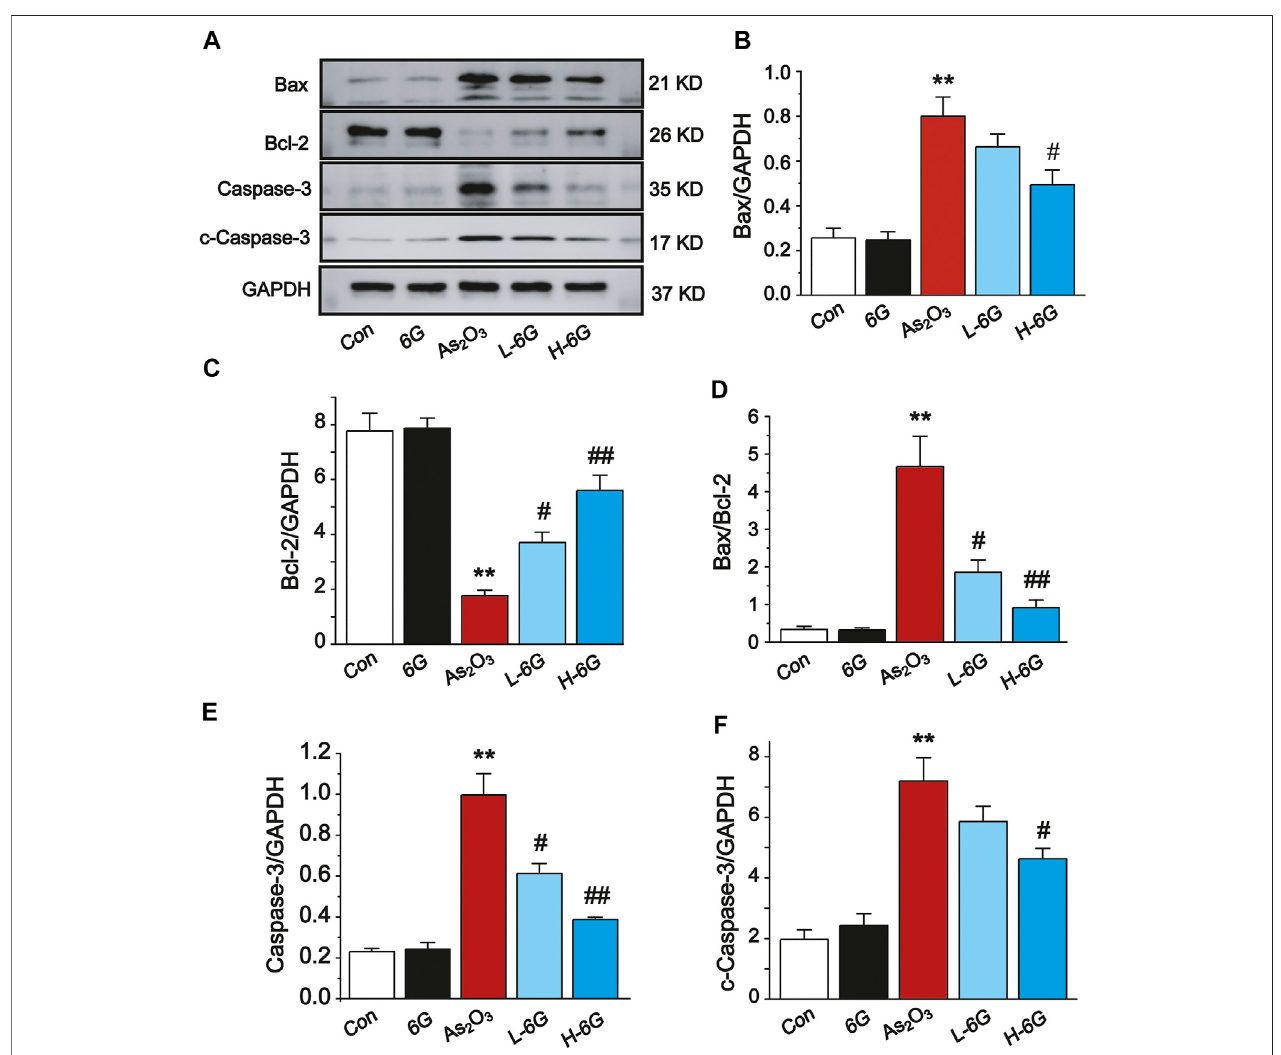
FIGURE 9 | Western blot analysis of Bcl-2, Bax, Caspase-3, and cleaved-Caspase-3 in cardiac homogenates prepared from mice, (A) The typical protein expression bands of each group. Bar graph of the expressions of Bax (B) , Bcl-2 (C) , Bax/Bcl-2 (D) , Caspase-3 (E) and c-Caspase-3 (F) in myocardial tissues. Data are expressed as mean ± SEM, n = 3. ** p < 0.01 as in comparison to the Con group and # p < 0.05, ## p < 0.05 as in comparison to the As 2 O 3